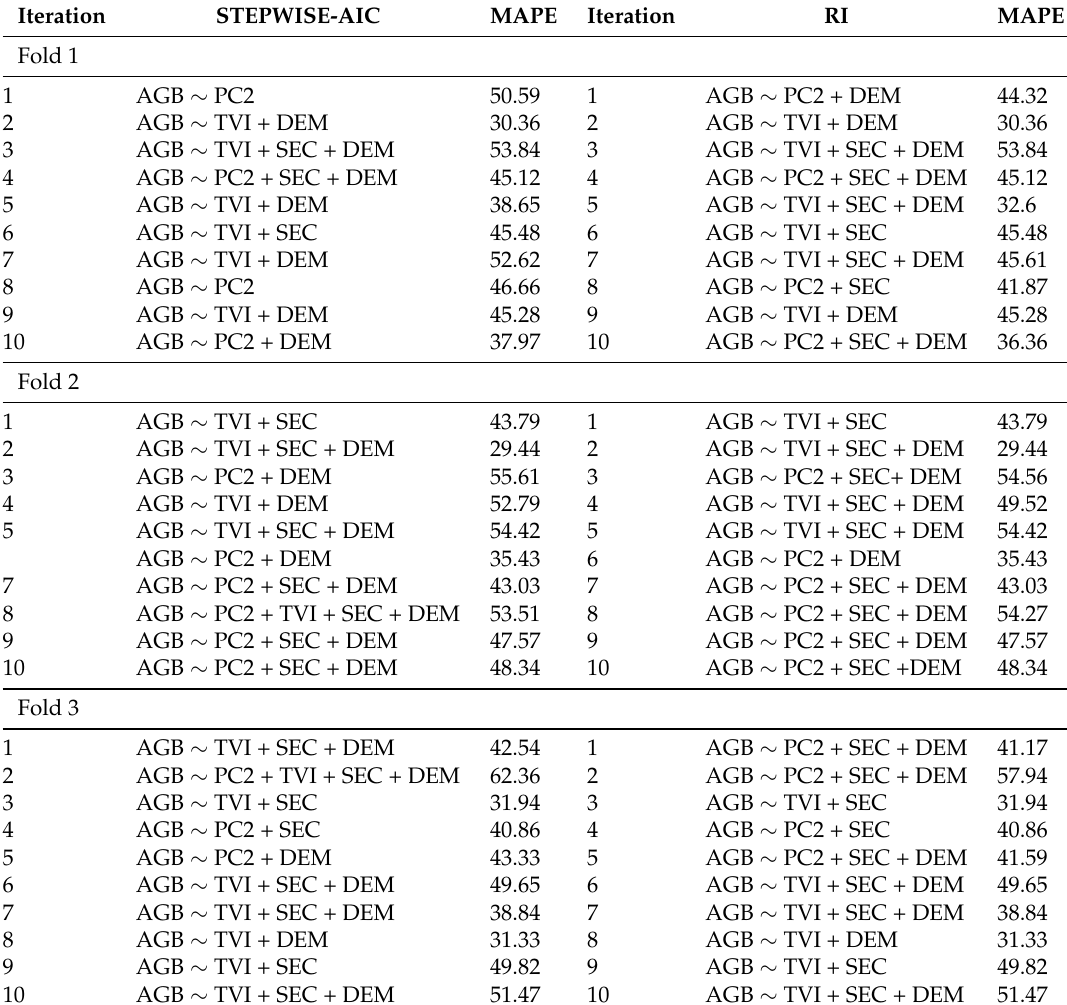
Table 7. Regression models generated with STEPWISE-AIC and RI in the triple cross validation and corresponding MAPE for the SPOT-5